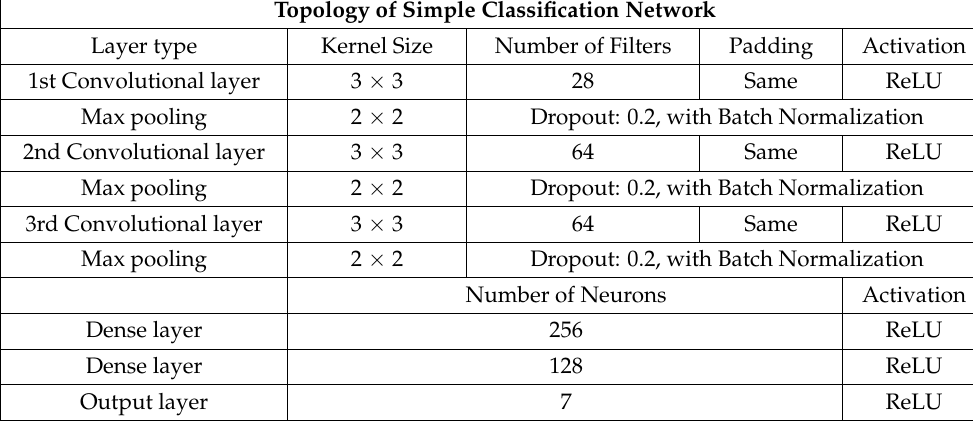
Table 3. Topology of simple classification